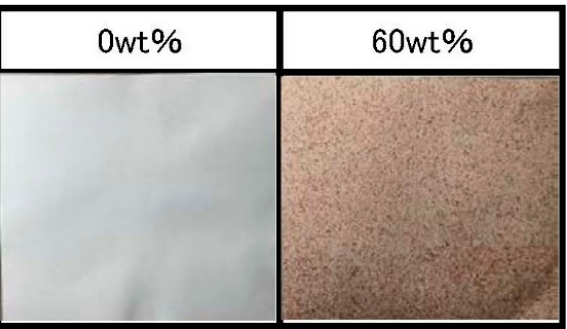
Figure 3. Compound paper (25 × 25 cm) comprising the inner skin of ‘Porotan’ chestnuts (60% weight).